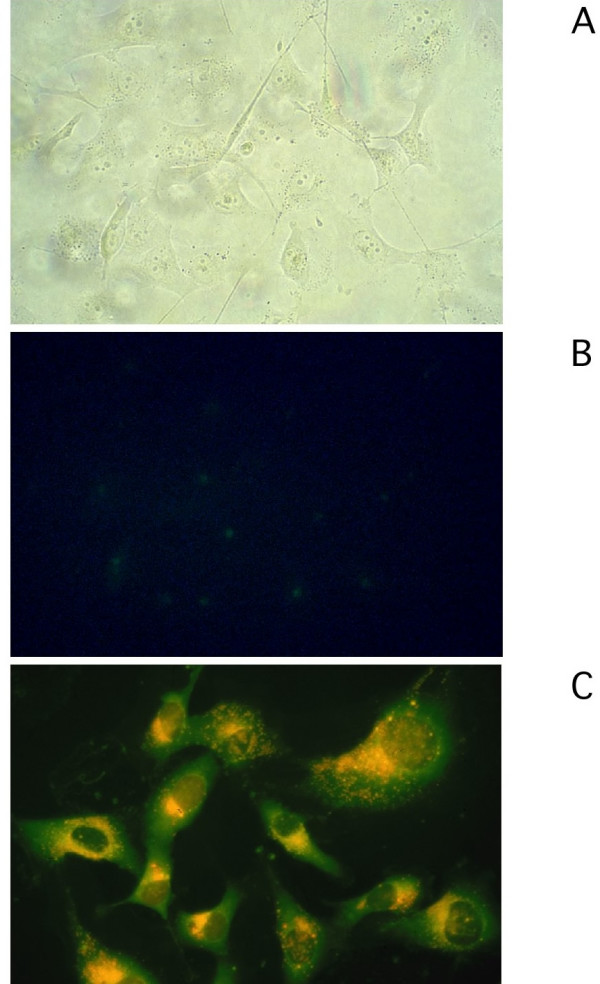
Anthracyclines are inhibitors of proteasome function. Incubation of ECV304 cells stably transfected with an Ub-GFP fusion protein with daunorubicin (100 μM, 16 h), caused accumulation of GFP throughout the cytoplasm (lower picture), indicating proteasome inhibition in living cells while untreated controls cells showed only little accumulation of GFP (A/B). Daunorubicin accumulated in the perinuclear region (C).